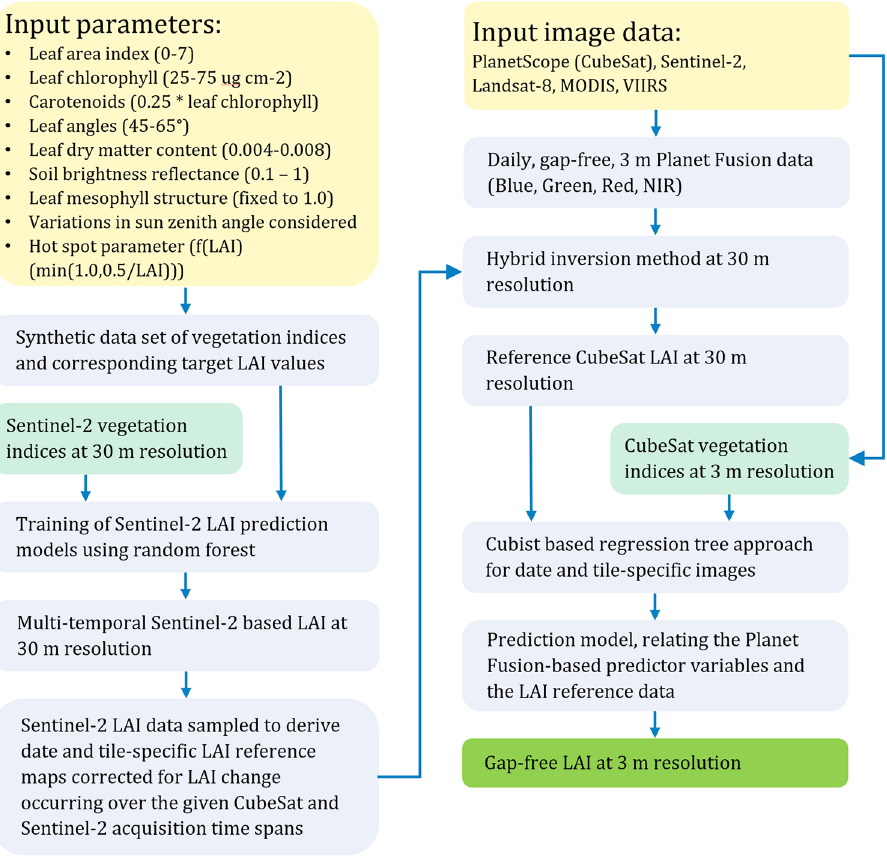
Figure 2. Flowchart of the processing workflow to produce daily gap-free LAI maps at 3 m resolution. The forward runs of PROSAIL produces a dataset of vegetation indices and corresponding LAI values, which are used to train the Sentinel-2-based LAI prediction models using random forest. The models are applied to the Sentinel-2 vegetation index data to produce Sentinel-2-based LAI at 30 m. The multi-temporal Sentinel-2 LAI data are then sampled to derive date and tile-specific LAI reference maps corrected for LAI change occurring over the given CubeSat–Sentinel-2 acquisition time spans. The relative LAI change is derived on the basis of a simple multi-variate regression model trained on the multi-day pool of Sentinel-2-LAI and co-incident Planet Fusion vegetation index predictor data. Finally, date and tile-specific model learning (Cubist) and prediction is performed by relating the Planet Fusion-based predictor variables and the LAI reference